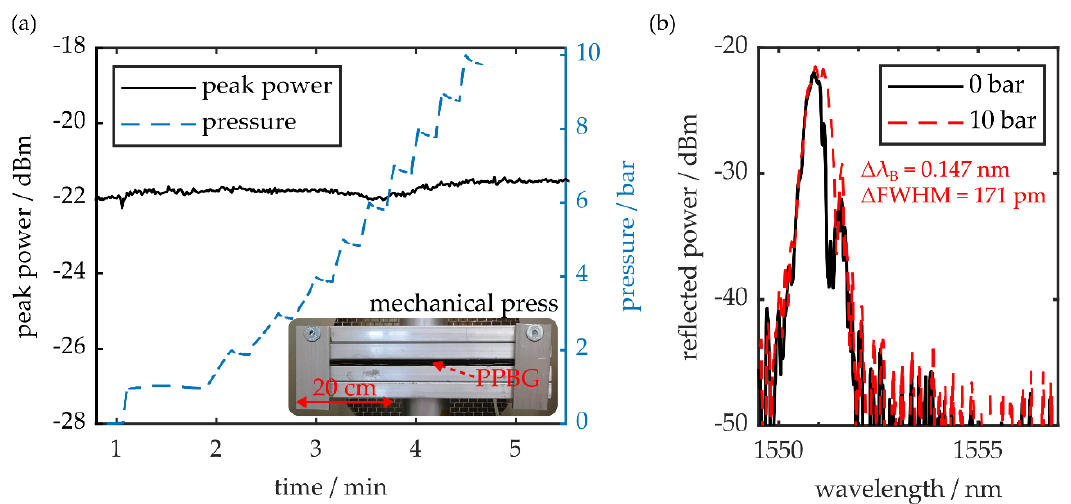
Figure 4. ( a ) Time trace of the PPBG’s peak signal power while the sensor is exposed to increasing pressure by a mechanical press. The inset shows the employed heated mechanical press. ( b ) Reflection peak without applied load and at a pressure of 10 bar.